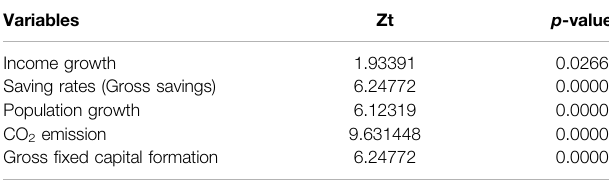
TABLE 6 | Cointegration test estimates for the Solow